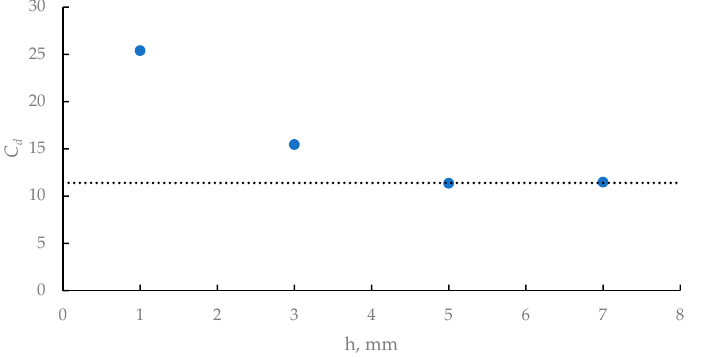
Figure 11. Discharge coefficients for different valve opening lifts.